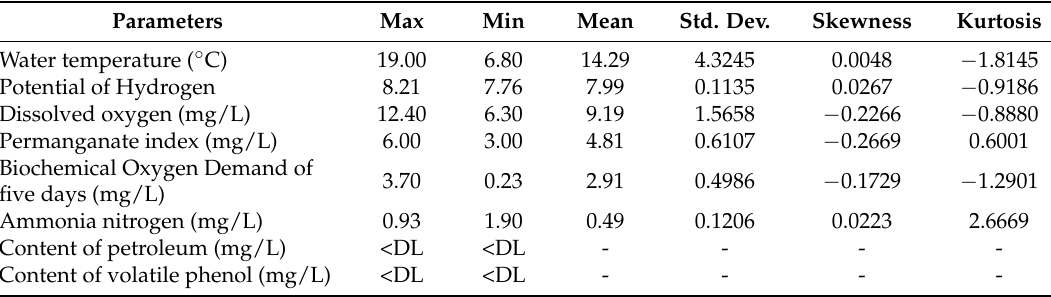
Table 2. Statistical properties of the water quality parameters.